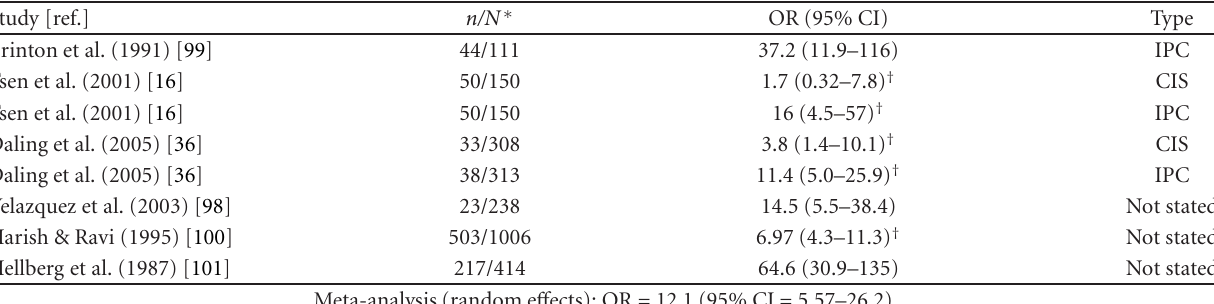
Table 2: Association between phimosis and penile cancer.